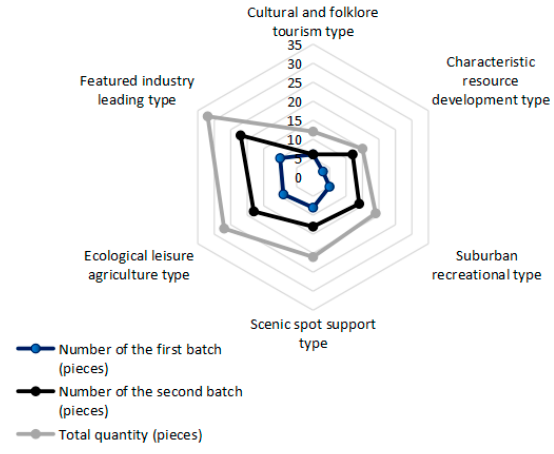
Figure 8. Types of key rural tourism villages in the Yellow River Basin.